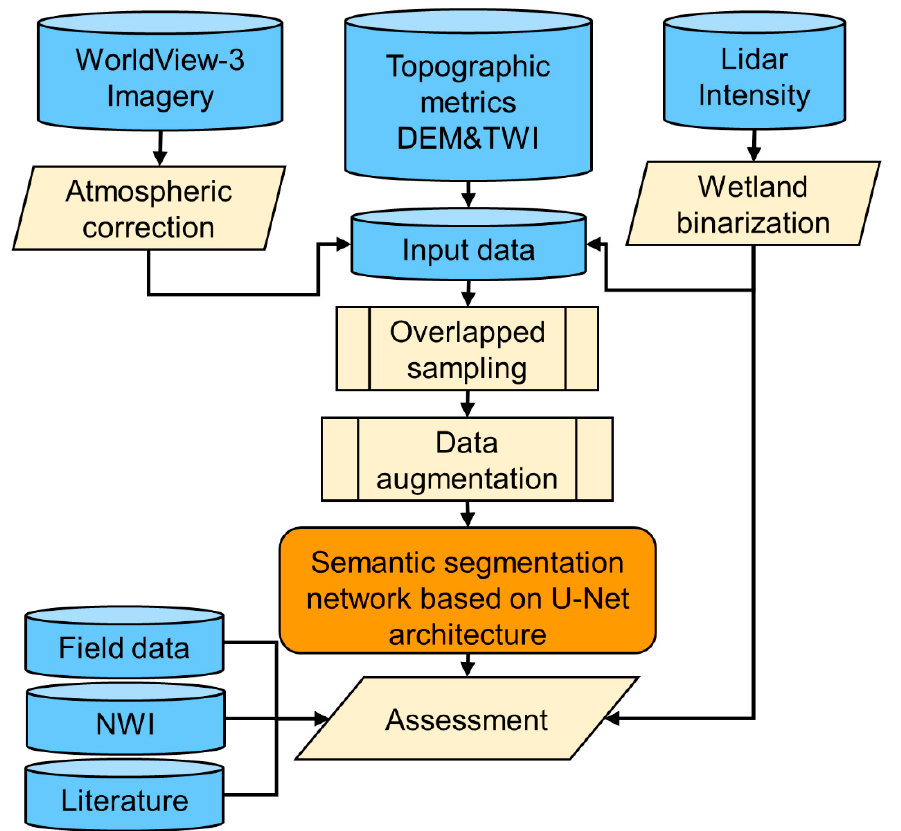
Figure 2. Workflow of wetland inundation mapping in this study. DEM: Digital Elevation Model, TWI: Topographic Wetness Index, NWI: National Wetland Inventory.